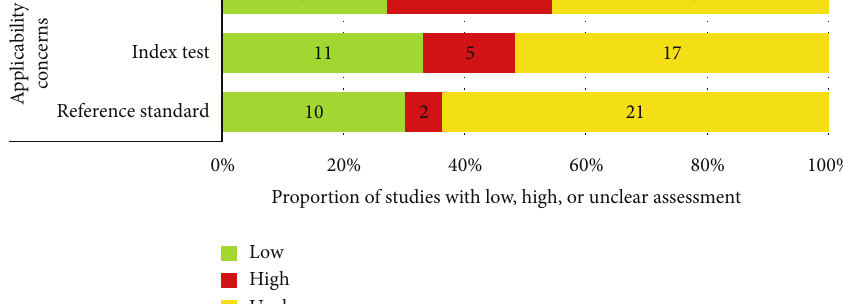
Figure 1: Quality of included primary studies assessed using QUADAS-2